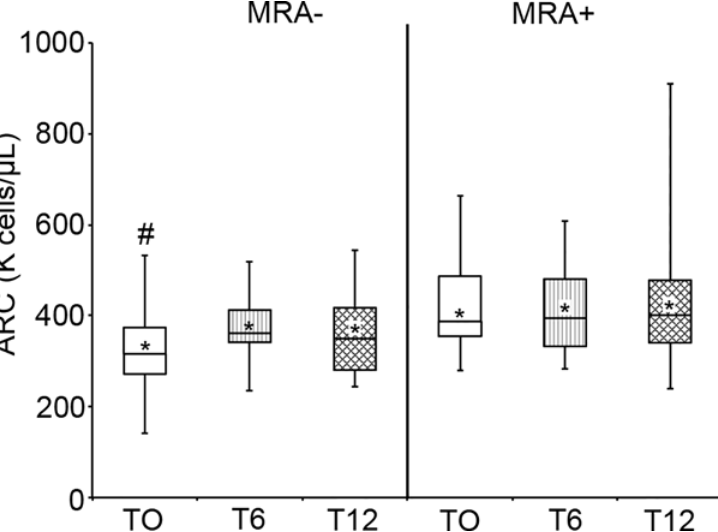
Fig 1. Pre-transfusion ARC during initial year of CTT. Mean pre-transfusion values for absolute reticulocyte counts [ARC (K cells/ μ L)] are shown at T 0, T 6, or T 12 for MRA- and MRA+ groups by the asterisk ( * ) in the box and whisker plot. Median [Interquartile Range] for both groups are illustrated by the horizontal lines within the box (MRA-: T 0 : 316.2 K/ μ l [271.4, 373.5]; T 6 : 361.2 K/ μ l [341.4, 412.2]; T 12 : 349.4K/ μ l [280.3, 417.2]; MRA+: T 0 : 387.6 K/ μ l [354.2, 486.5]; T 6 : 394.3 K/ μ l [332.6, 480.3]; T 12 : 400.8 K/ μ l [340.6, 478.0]). # denotes a statistically significant difference between mean (and median) T 0 values for MRA+ and